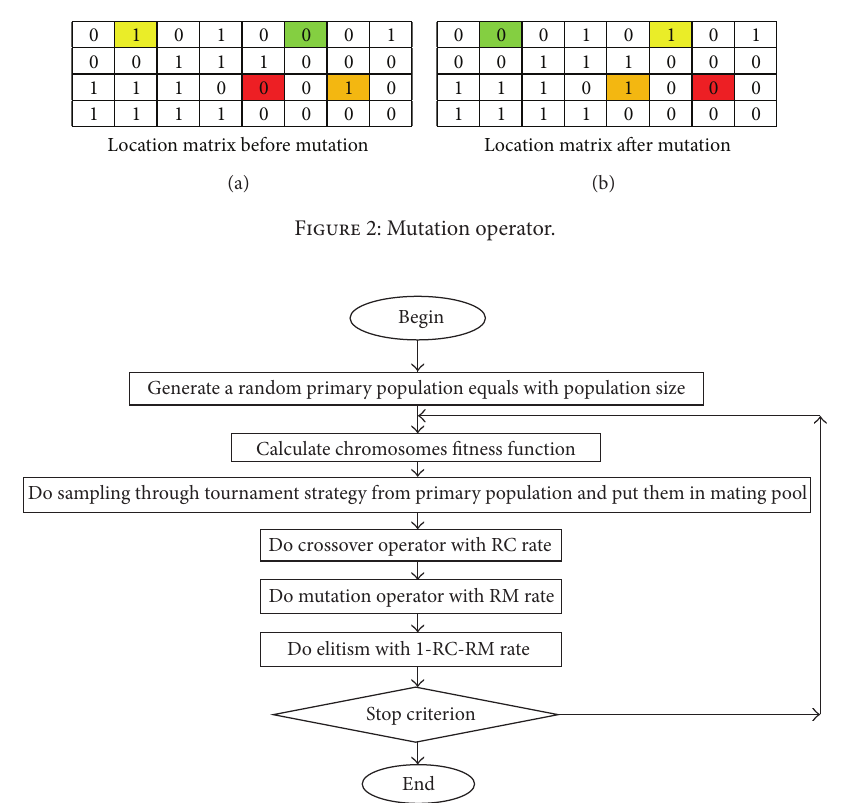
Figure 1: Crossover operator.